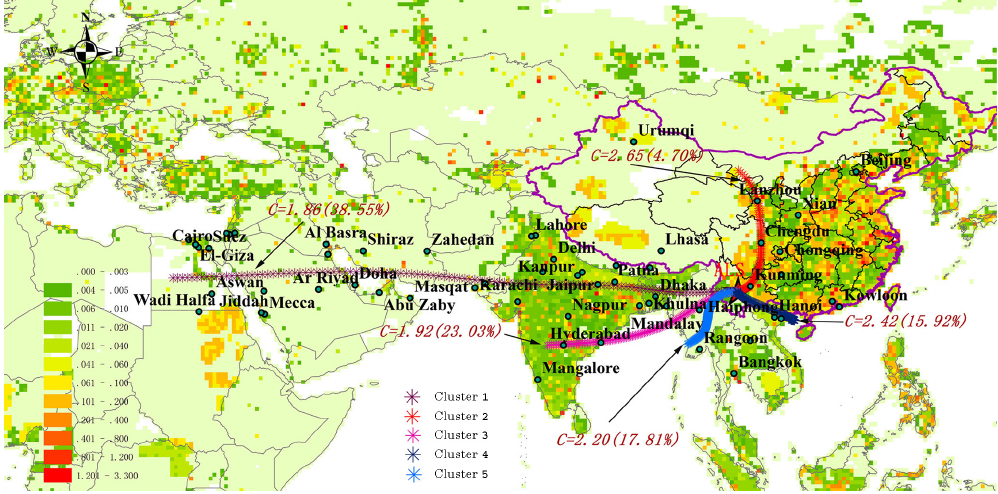
Figure 7. Air mass backward trajectory analysis for long-range transport to ALS. Most of these backward trajectories consisted of air masses that originated from south and southeast Asia and were accompanied by lower Hg levels. Air masses originating from inland China were less frequent and accompanied by higher Hg